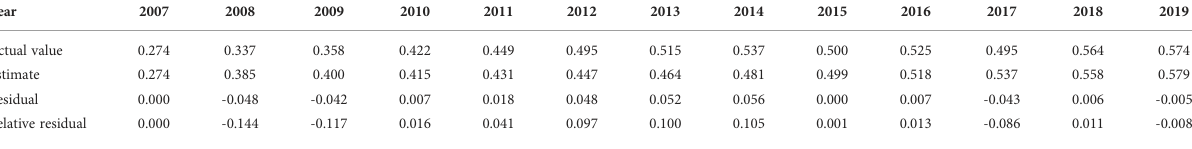
TABLE 5 Grey prediction residual error of conjugate degree of marine composite